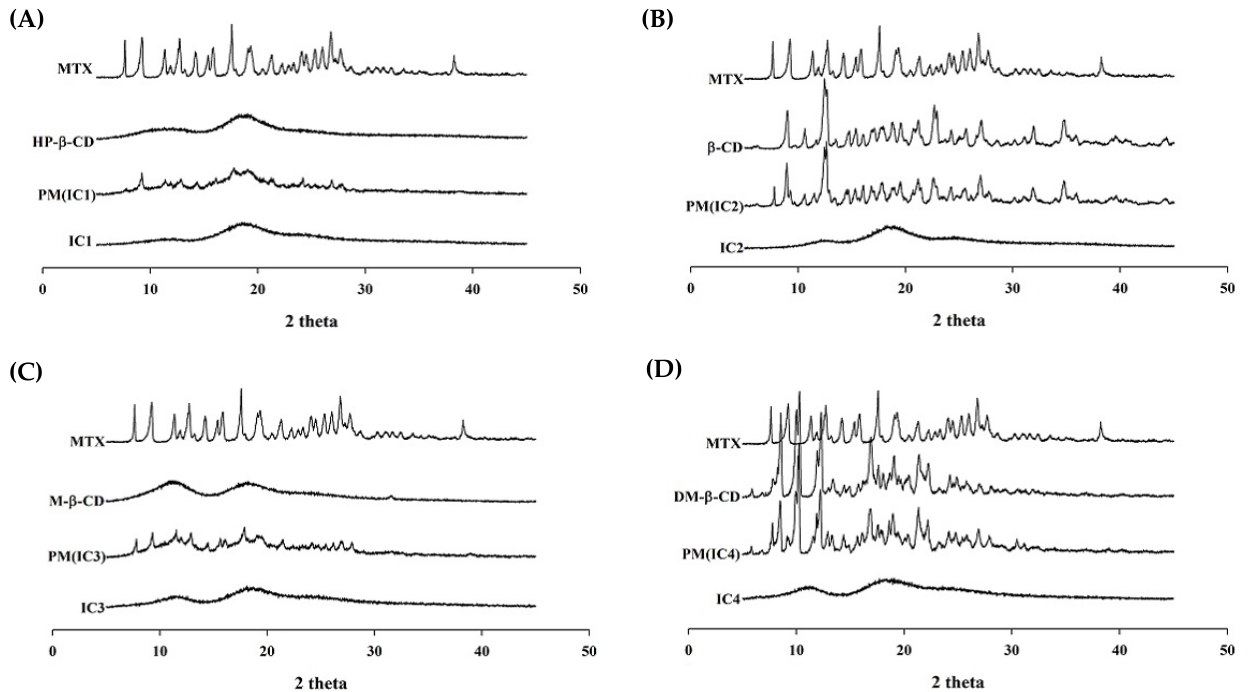
Figure 5 . PXRD patterns of the MTX powder, cyclodextrins, physical mixtures, and MTX-CD inclusion complex formulations: ( A ) MTX/HP- β -CD inclusion complex (IC1); ( B ) MTX/ β -CD inclusion complex (IC2); ( C ) MTX/M- β -CD inclusion complex (IC3); and ( D ) MTX/DM- β -CD inclusion complex (IC4).